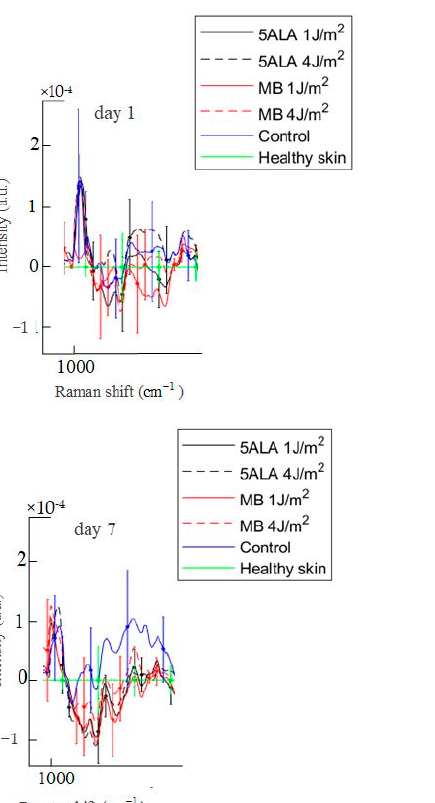
Figure 13. Difference between the wound Raman spectra of all groups subtracting the healthy skin mean Raman spectrum in the 1200–1750 cm − 1 spectral range. The Raman spectra are presented in terms of mean ± StD values. Black line—5ALA 1 J/cm 2 , black dashed line—5ALA 4 J/cm 2 , red line—MB 1 J/cm 2 , red dashed line—MB 4 J/cm 2 , blue line—control, green line—healthy skin (the number of processed Raman spectra was equal to 30 for each group).